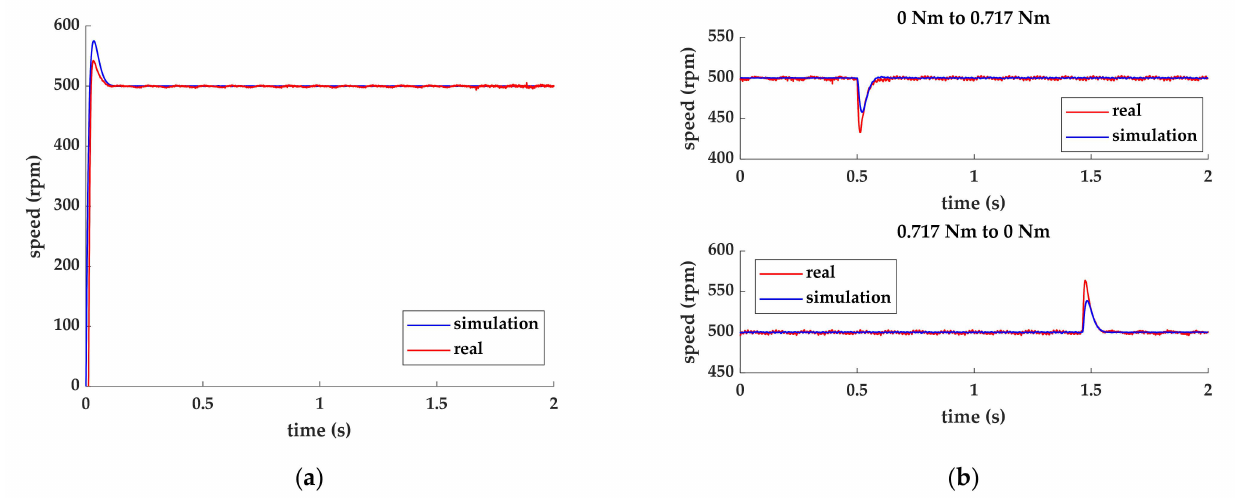
Figure 9. Motor speed response: ( a ) transient and steady state response, and ( b ) speed response with disturbance load of 0.717 Nm.